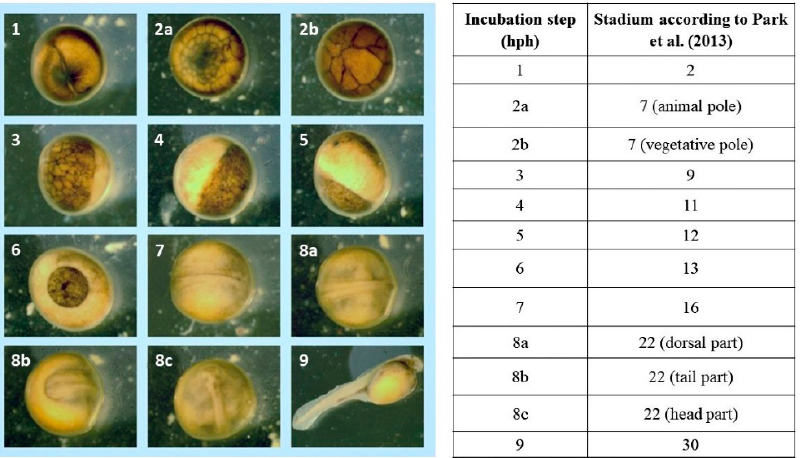
Figure 1. Embryonic development of hybrids [ ♀ Siberian sturgeon × Russian sturgeon] × ♂ Siberian sturgeon offspring (group A) according to Park et al. [10].